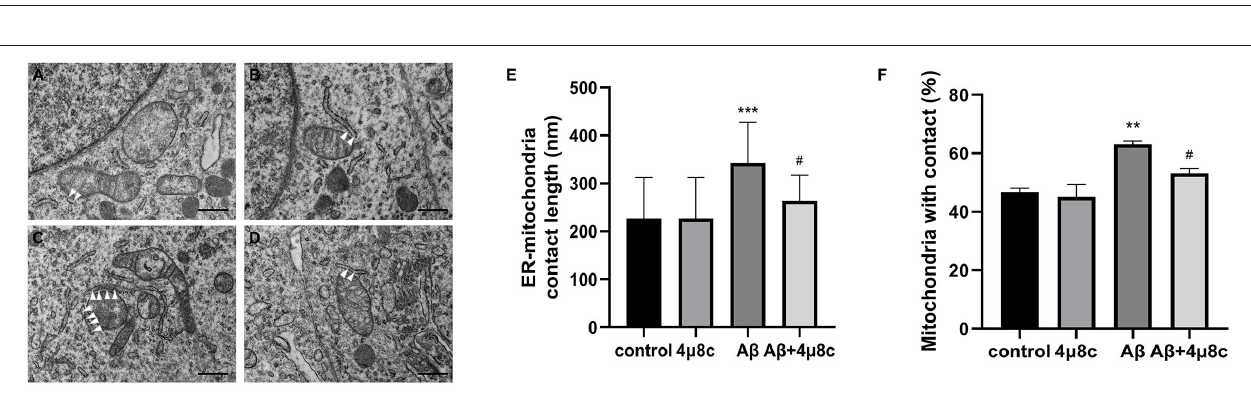
FIGURE 4 | The effect of IRE1 α -XBP1 on the length of endoplasmic reticulum (ER)–mitochondria contact sites in A β -treated cells. Cells were pretreated with or without 20 µ M 4 µ 8c for 2h, followed by treatment with 20 µ M A β 25–35 for 4h. (A–D) Representative electron micrographs of ER–mitochondria contact sites in (A) the control group, (B) the 4 µ 8c group, (C) the A β group, and (D) the A β + 4 µ 8c group cells. The white triangles indicate ER–mitochondrial contact sites. Scale bar = 0.5 µ m. (E) Quantitative analysis of average length of the ER–mitochondria association. (F) Bar graphs show the percentage of mitochondria in contact with ER. (control-72 mitochondria, 4 µ 8c-79 mitochondria, A β -83 mitochondria, A β + 4 µ 8c-75 mitochondria). The data are presented as mean ± SD ( n = 3), ** P < 0.01 compared with the control. *** P < 0.001 compared with the control. # P < 0.05 compared with the A β 25–35-alone